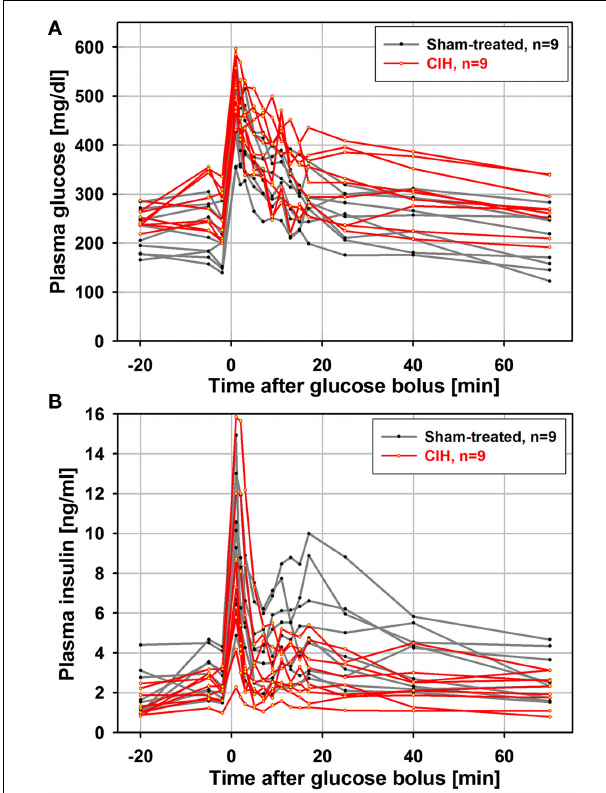
FIGURE 1 | Individual glucose and insulin curves obtained from the ivgtt conducted under anesthesia with nine rats subjected to CIH and nine rats subjected to sham gas exchanges for 35days. Glucose bolus (400mg/kg) was injected at time zero. Note a clear elevation of glucose levels in CIH rats (A) and both a downward shift and reduced second peak of insulin release in CIH rats (between 11 and 25min after glucose bolus injection) (B)